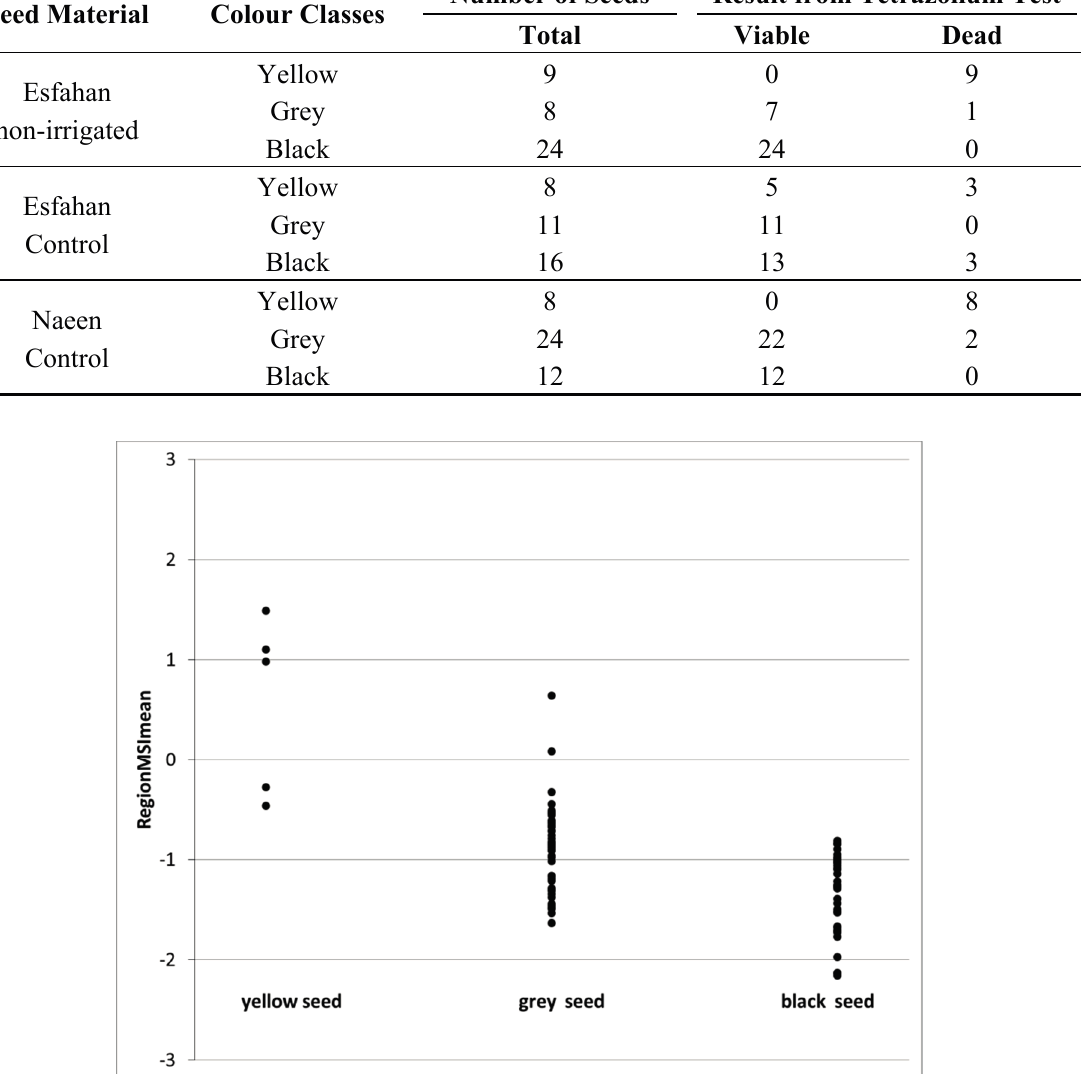
Figure 4. Positive RegionMSI mean values is predicted as dead seeds and negative values predicted as viable seeds for seeds with enzyme activities in the tetrazolium test. Three seed classes divided due to the colour of seed coat (yellow, grey and